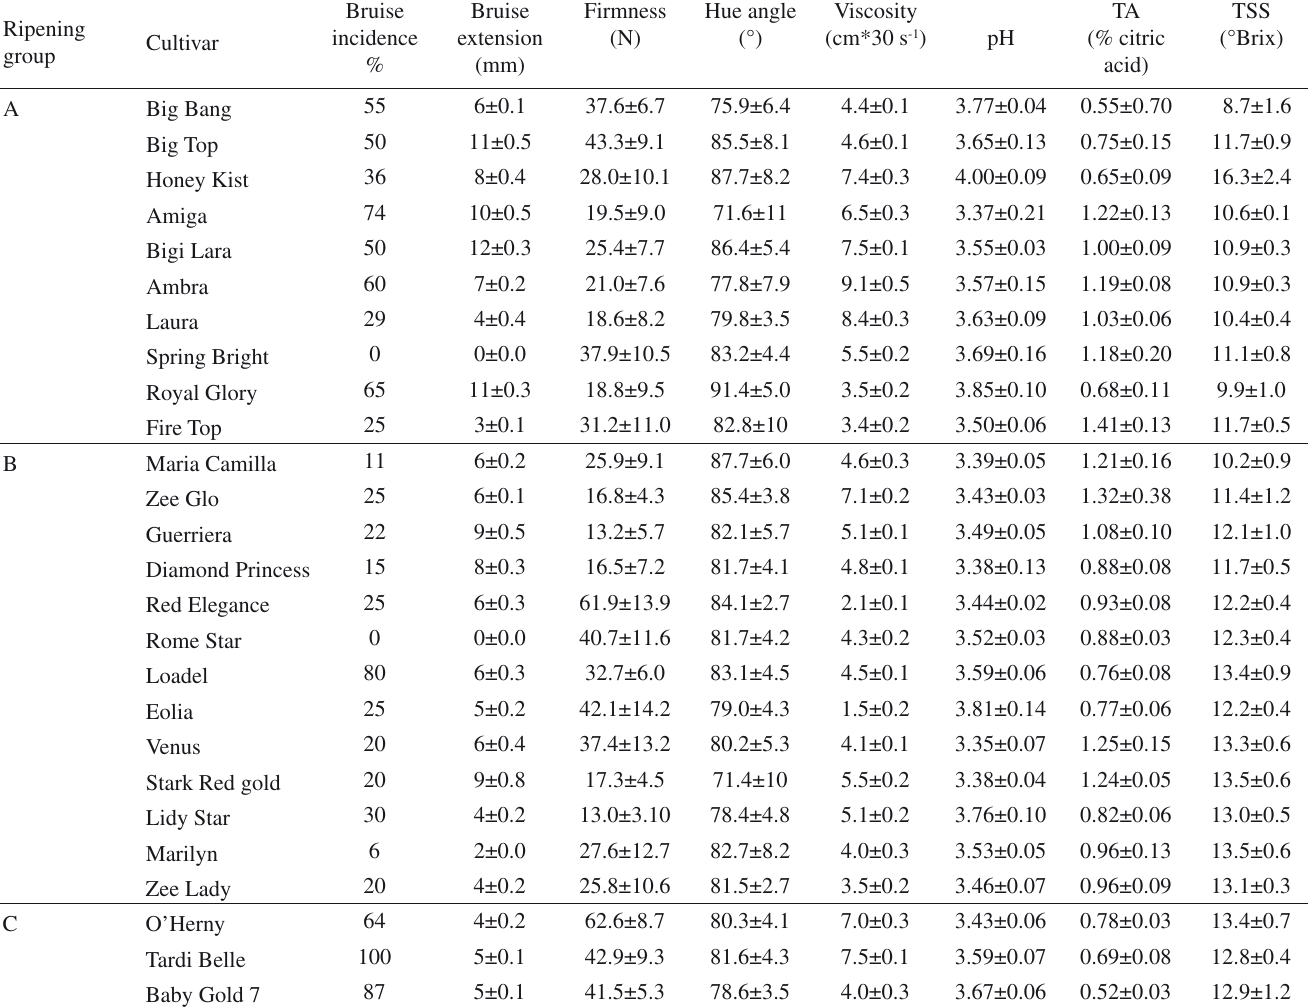
Table 2 - Chemical and physical parameters evaluated on peach, nectarine and clingstone peach varieties for Group A (early maturing), Group B (middle maturing) and Group C (late maturing)